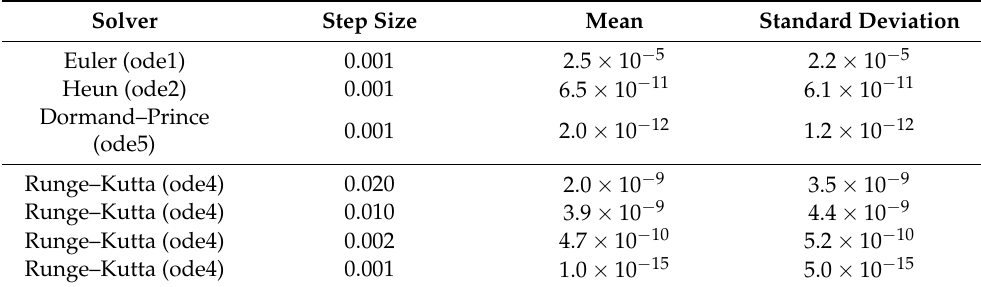
Figure 3. Comparison of quaternion normalizations (on the ordinate) for different step sizes using the Runge–Kutta solver. Standard deviations for 50 (black dashed line), 250 (green dotted line), 500 (red dot-dashed line), and 1,000 Hertz (blue solid thin line) sample rates are displayed. Time in seconds is displayed on the abscissa with quaternion normalization on ordinate. Table 5. Quaternion normalization errors for different solver schemes 1